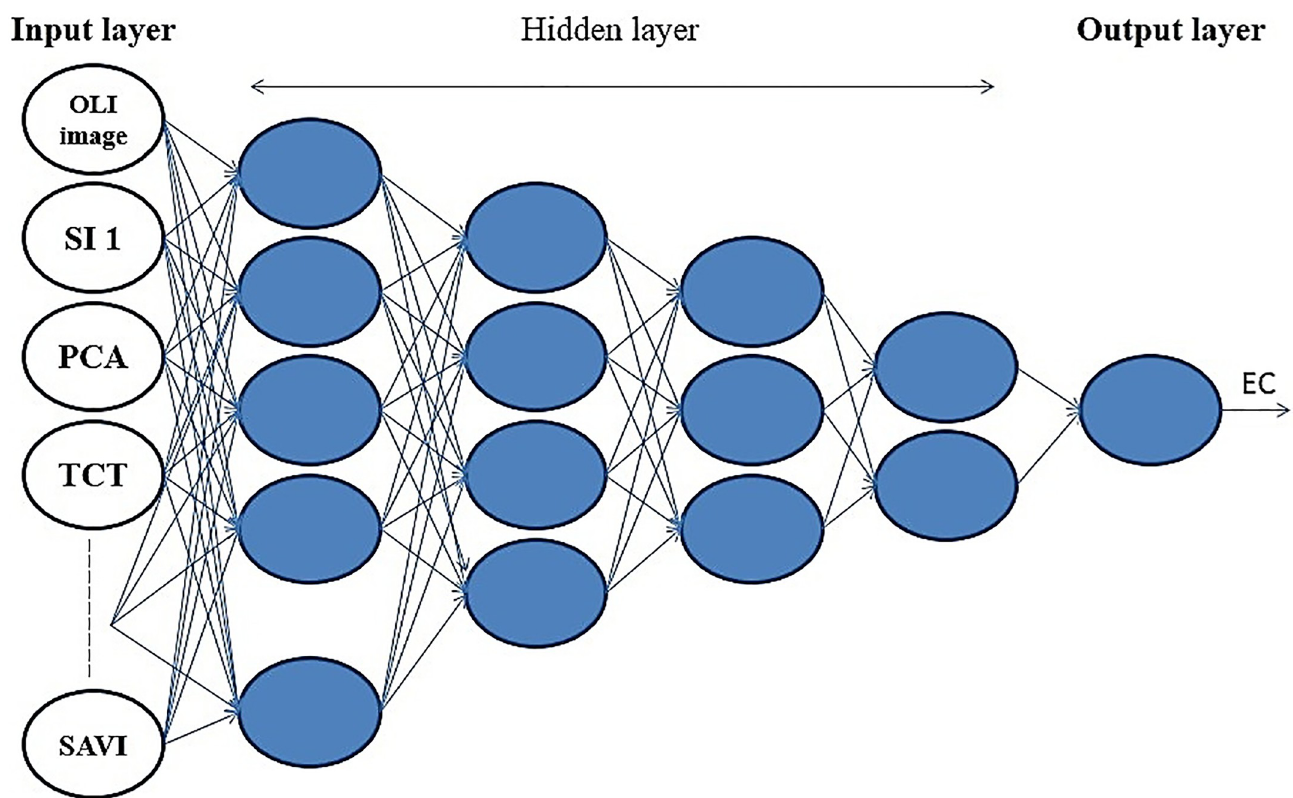
Fig 2. Schematic of the MLP model used in this study, including one input/target layer and four hidden layers.